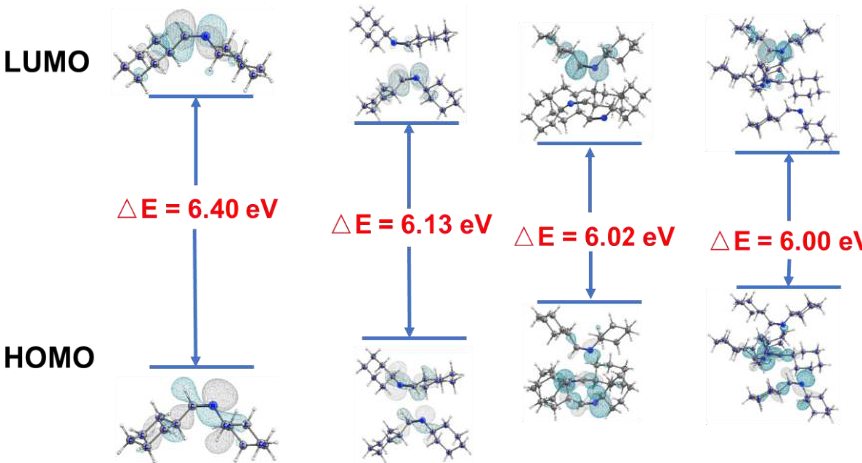
Figure 7. Optimized conformations of various imine 4 molecule(s) linked together by hydrogen bonds and their molecular orbital surfaces of HOMOs and LUMOs. From left to right, the molecule number in the model is 1 to 4. Table 2. HOMO-LUMO energy gaps of the aggregates of imines with various molecules in optimal conformations. Imine